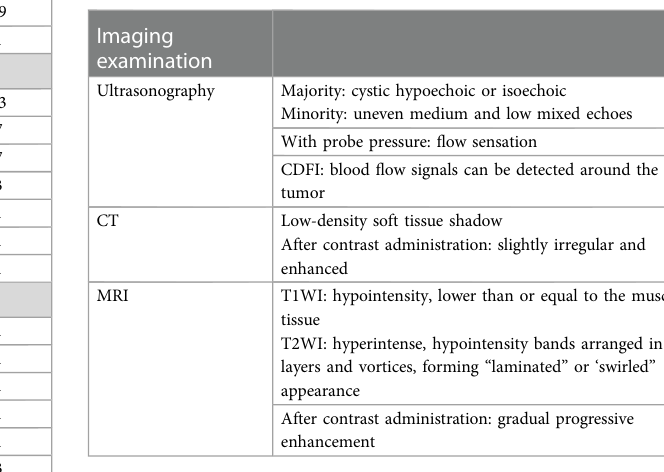
TABLE 2 The features of the imaging examination of AAM.